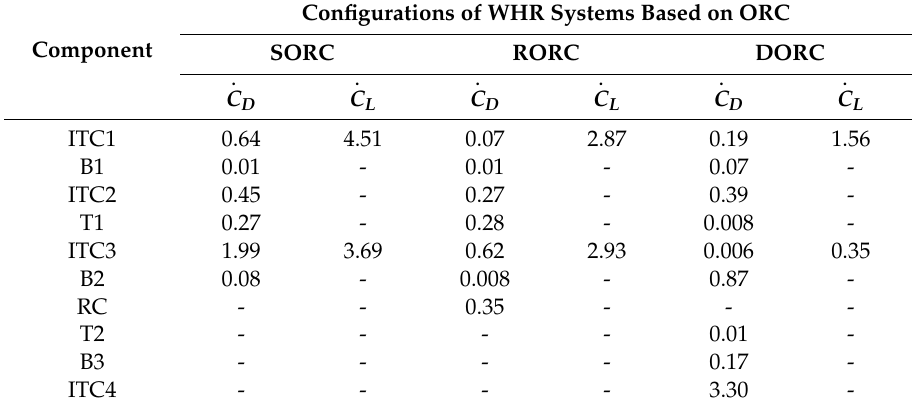
. C L X 10 − 3 ) for the WHR configurations.